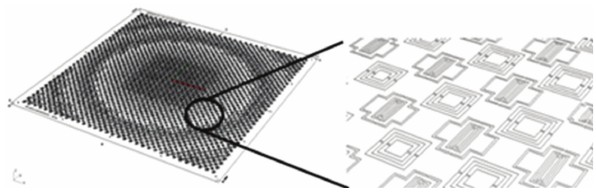
Figure 3: Schematic view of the original